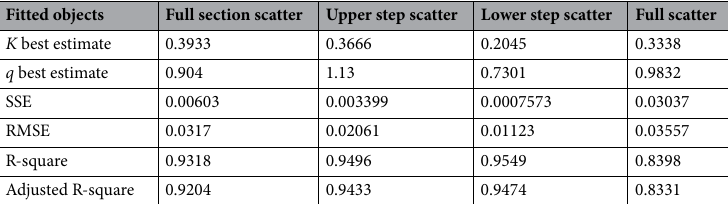
Table 8. Model fitting parameters.